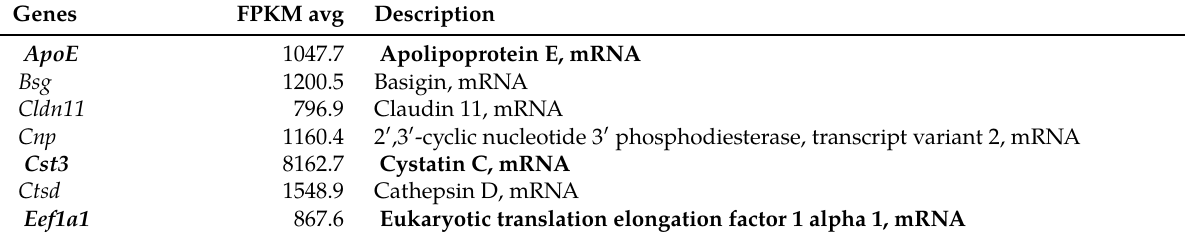
Table 8: Most highly expressed genes (average FPKM > 700) in the [5] study (see Materials and Methods). Genes FPKM avg